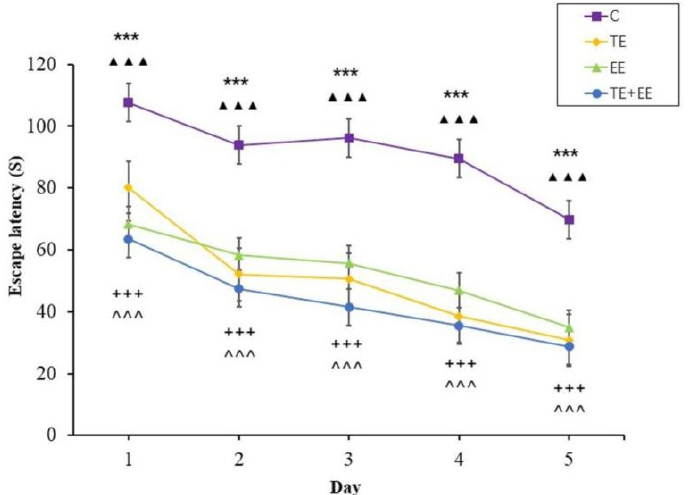
Figure 2. Average escape latency in the Control (C), Treadmill Exercise (TE), Enriched Environment (EE) and Treadmill Exercise Combined with Enriched Environment (TE + EE) groups ( N = 10, x ± s ). Note: EE group versus C group, *** p < 0.001; TE group versus C group, ▲▲▲ p < 0.001; TE + EE group versus C group, + + + P < 0.001; TE + EE group versus EE group, ^ ^ ^ p < 0.001. Data from the number of platform crossings showed a statistically significant differ- ence between the exercise effect [ F (1,36) = 56.90, p < 0.001, partial η 2 = 0.61], the enriched